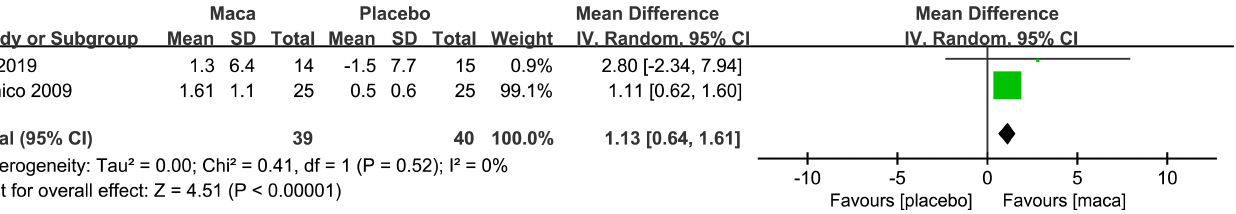
FIGURE 3. Forest plot of the effect of maca on erectile